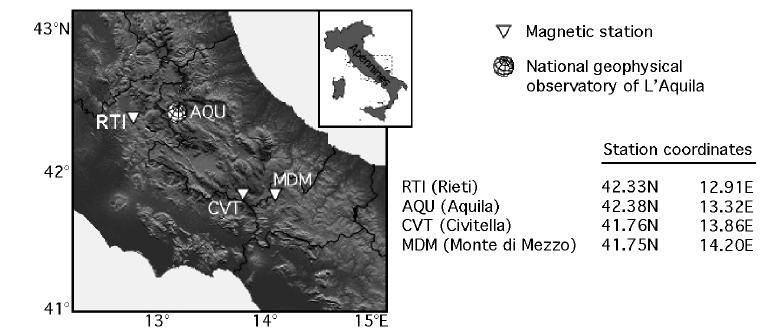
Fig. 1. Map of target area showing the location and geographic coordinates of magnetometer stations MDM, CVT, RTI and the national geomagnetic observatory at